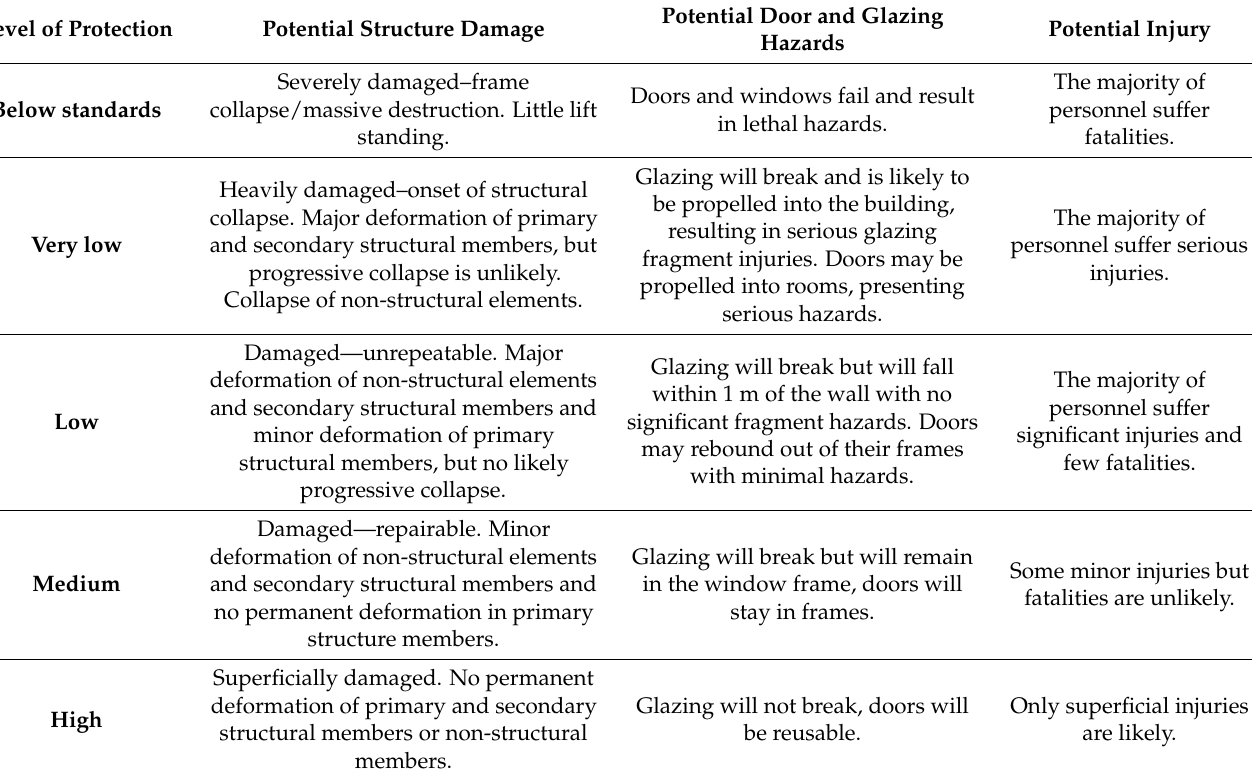
Table 2. The levels of protection of buildings’ different components from blast damages. Source: [22]. Level of Protection Potential Structure